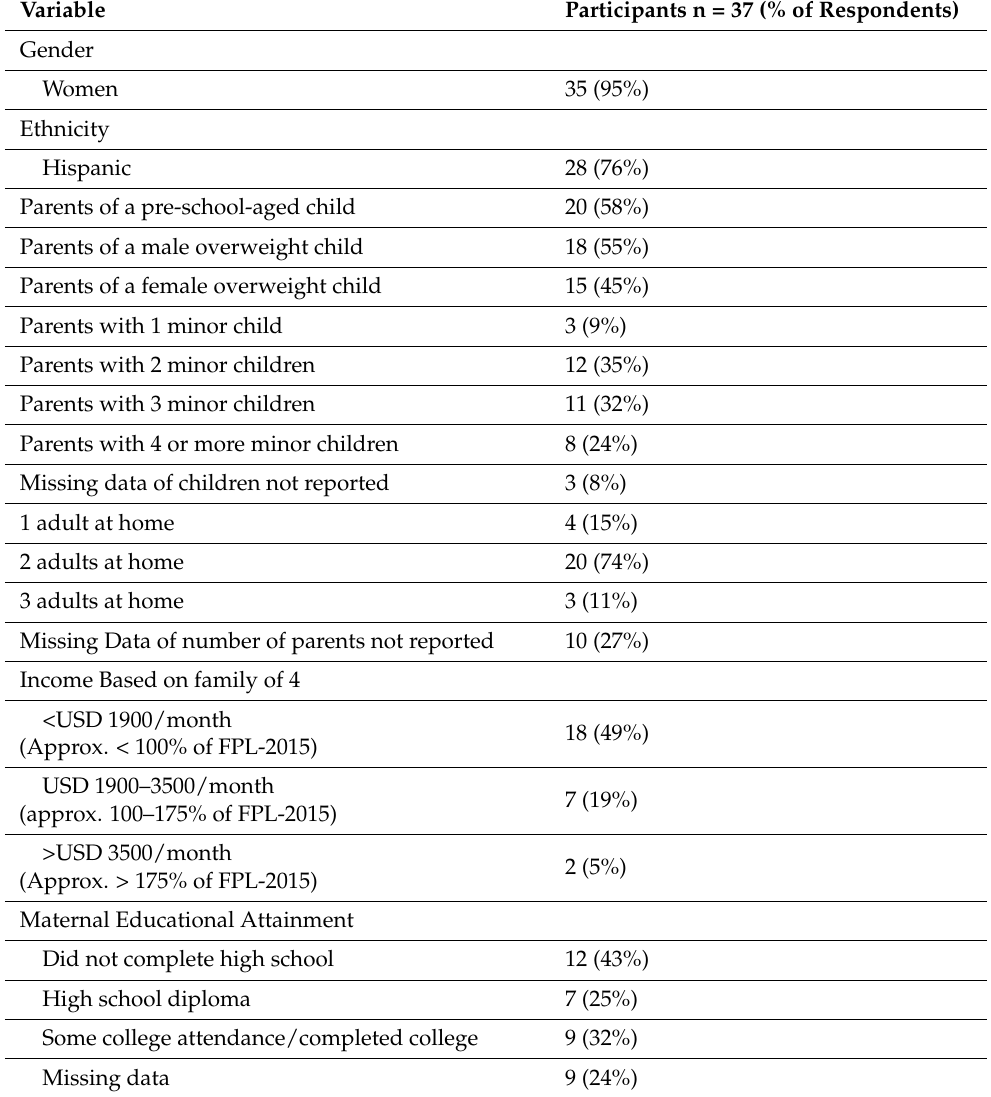
Table 2. Focus group participant demographic